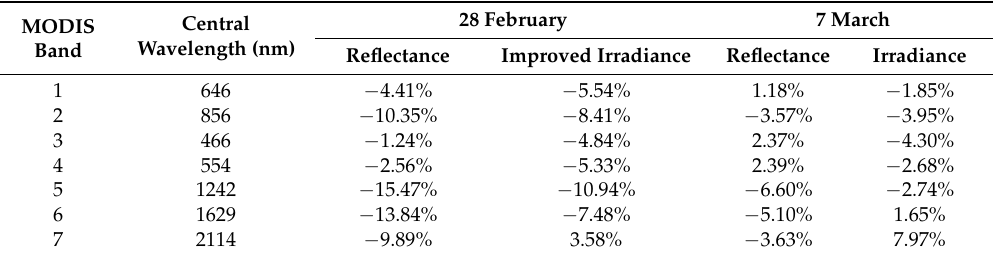
Table 8. Differences between the TOA radiance predicted by the vicarious methods (i.e., the